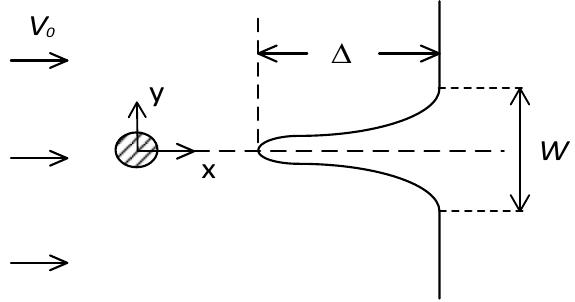
Figure 5. Wind speed pattern in front of the tower.